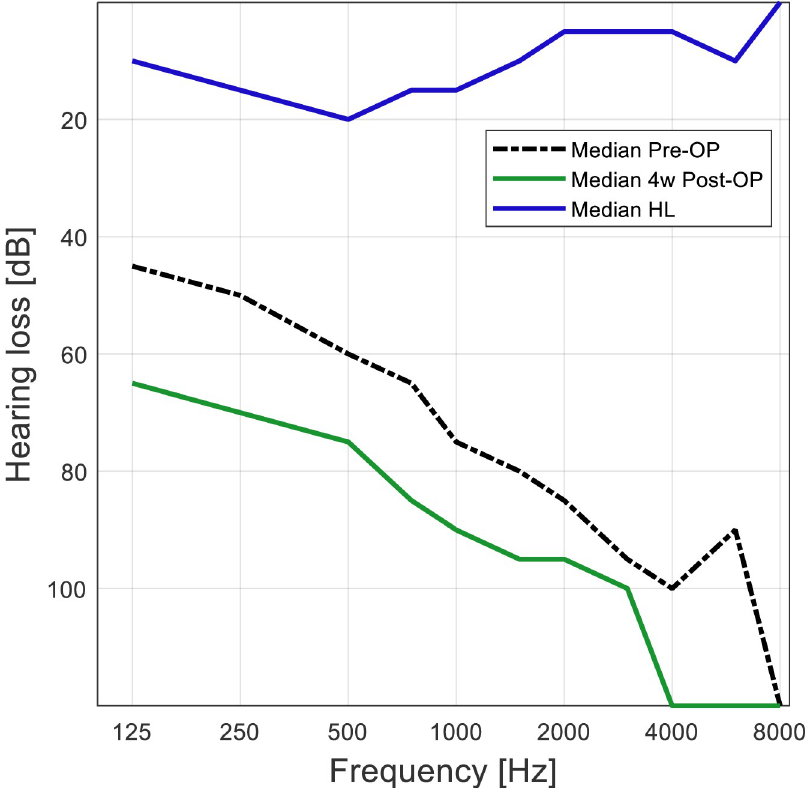
Fig 4. Median hearing loss, calculated as the difference between pre-operative hearing and 4 weeks post-surgery, at each frequency for 47 subjects.